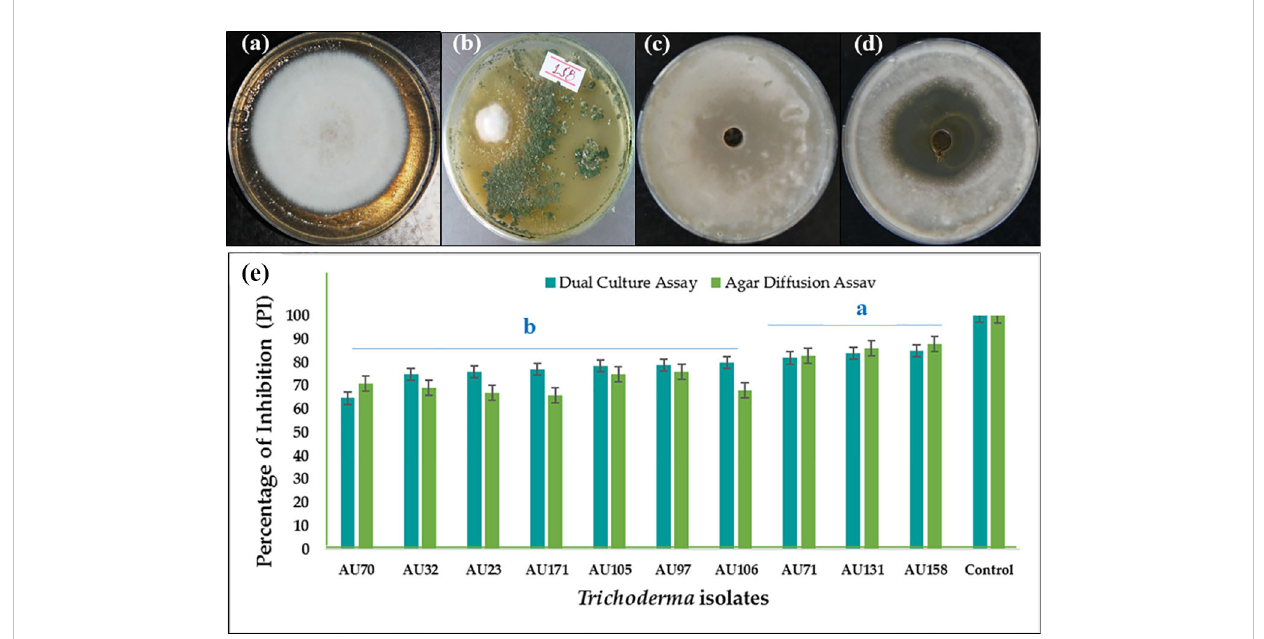
FIGURE 1 In vitro antagonistic activity of 10 Trichoderma isolates against F . xylarioides in dual culture and agar diffusion assays. (A) F. xylarioides control for dual culture assay, (B) in vitro dual culture assay showing inhibition of F . xylarioides by T. longibrachiatum AU158, (C) F . xylarioides control for agar diffusion assay, (D) agar diffusion assay showing inhibition of F . xylarioides by T. longibrachiatum AU158 and (E) bar graph for both dual culture and agar diffusion assay. Each value is the average of three duplicate samples with standard error, and various alphabets shown in superscript indicate mean treatments that are substantially different according to Tukey ’ s HSD posthoc test at p ≤ 0.05. Trichoderma isolates: T. viride AU23, T. longibrachiatum AU32, T. koningiopsis AU70, T. asperelloides AU71, T. asperellum AU97, T. harzianum AU105, T. aethiopicum AU106, T. asperellum AU131, T. longibrachiatum AU158 and T. asperellum